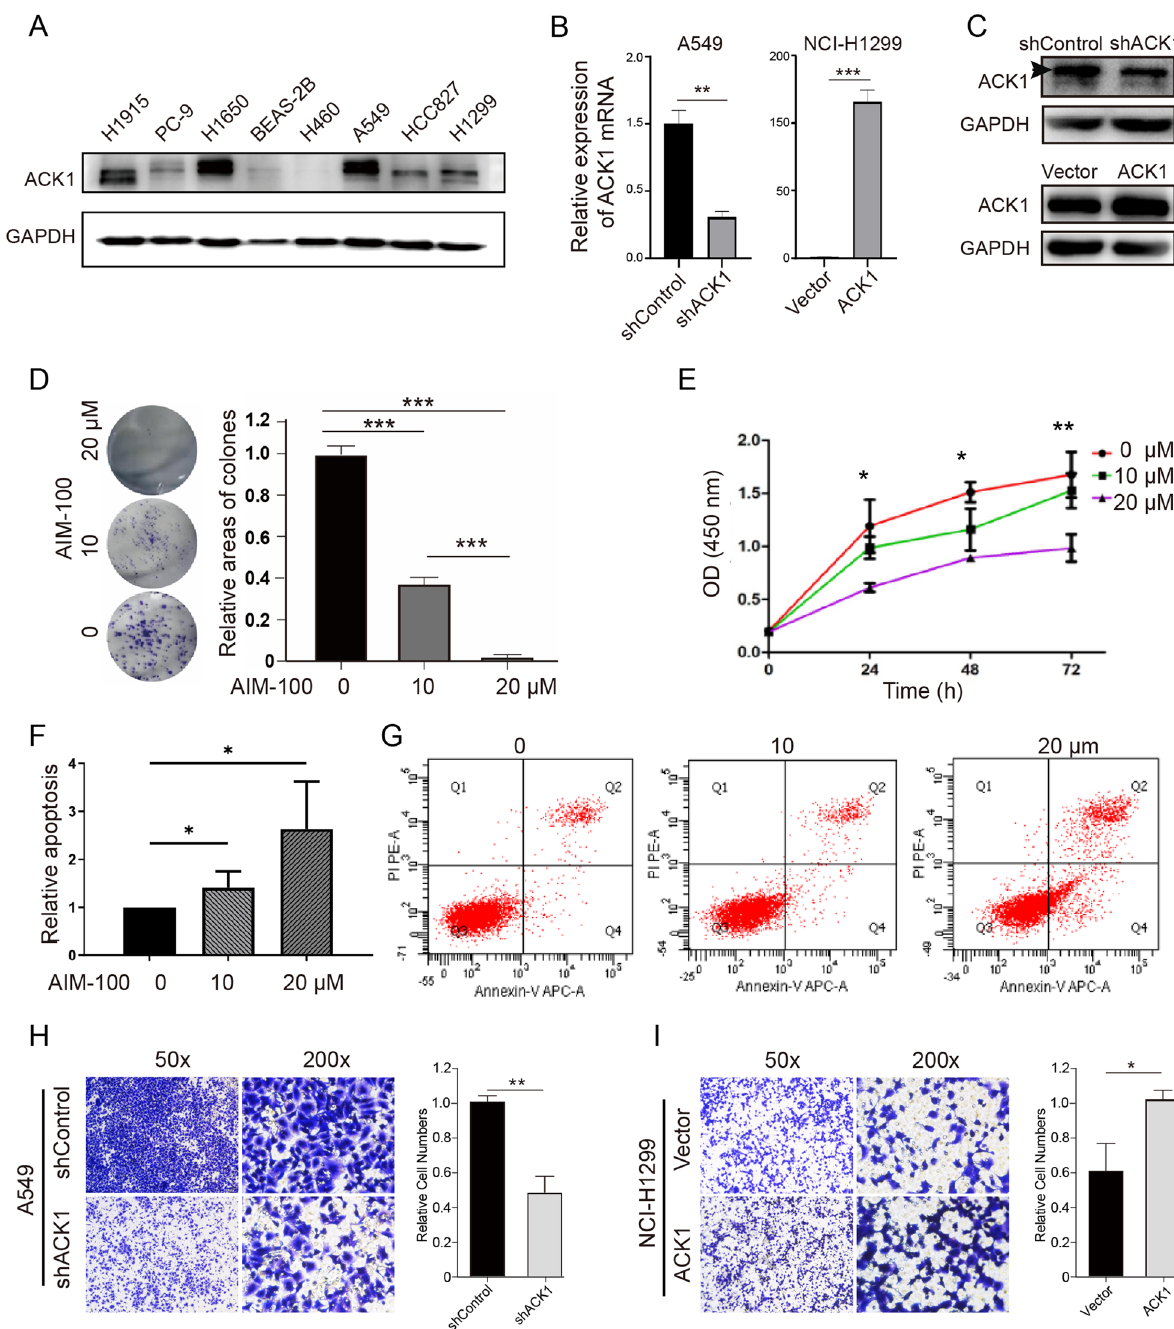
Fig. 5 The function of ACK1 in lung cancer cells. A Expression of ACK1 in human lung bronchial epithelial (Beas-2B) and indicated lung cancer cell lines. B , C RT-qPCR B and western blot analyses C were used to verify ACK1 at mRNA and protein levels in A549 cells infected with lenti-shACK1 and NCI-H1299 cells with empty vectors and ACK1 overexpression lentiviral vectors. The black arrowhead indicated the ACK1 bands in the blot. The colony formation D and CCK8 E assays showed the effect of ACK1 inhibitor (AIM-100) on A549 cell viability and proliferation capacity, respectively. Cells were allowed to grow for ten days to form visible colonies. F , G The impact of AIM-100 on apoptosis of A549 cells at 24 h after treatments. H , I After an incubation of 18 h, the effects of knockdown and overexpression of ACK1 on cell migration were measured using a transwell assay in A549 H and NCI-1299 I NSCLC cells, respectively. *P < 0.05, **P < 0.01, ***P <